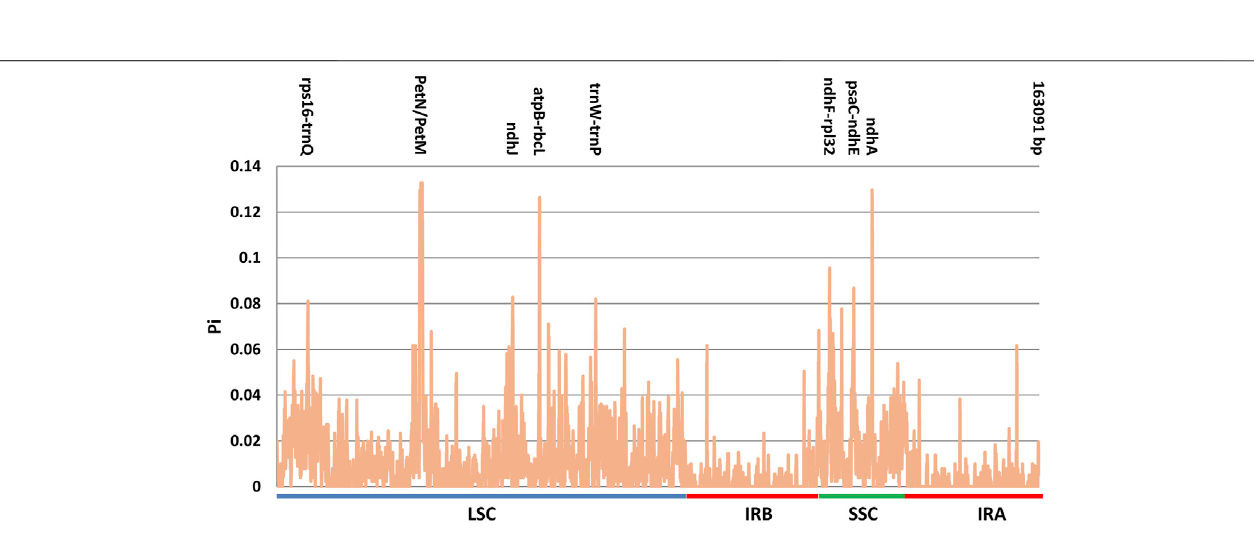
Frontiers in Genetics |